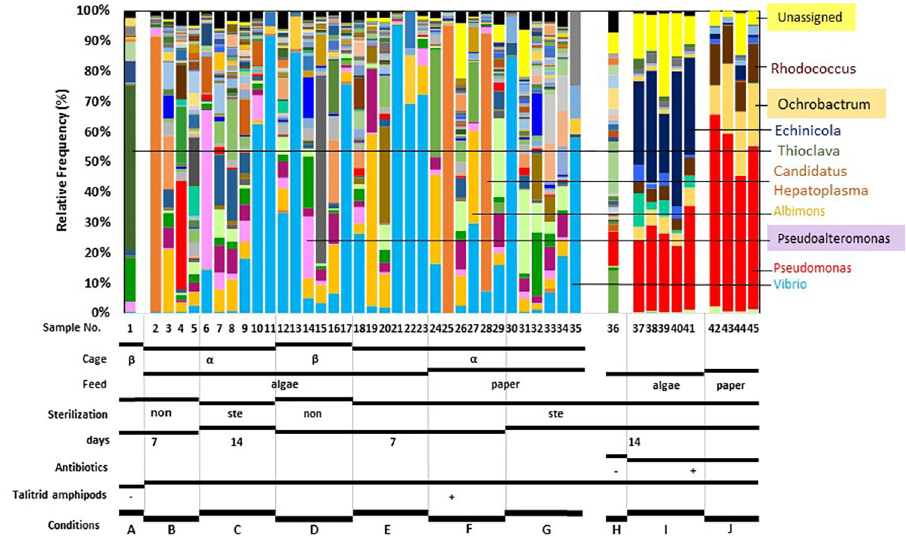
Fig 3. Bar plot of the relative frequency of 16S bacterial data at the genus level. The frequencies of some genera are shown in S1 Table.